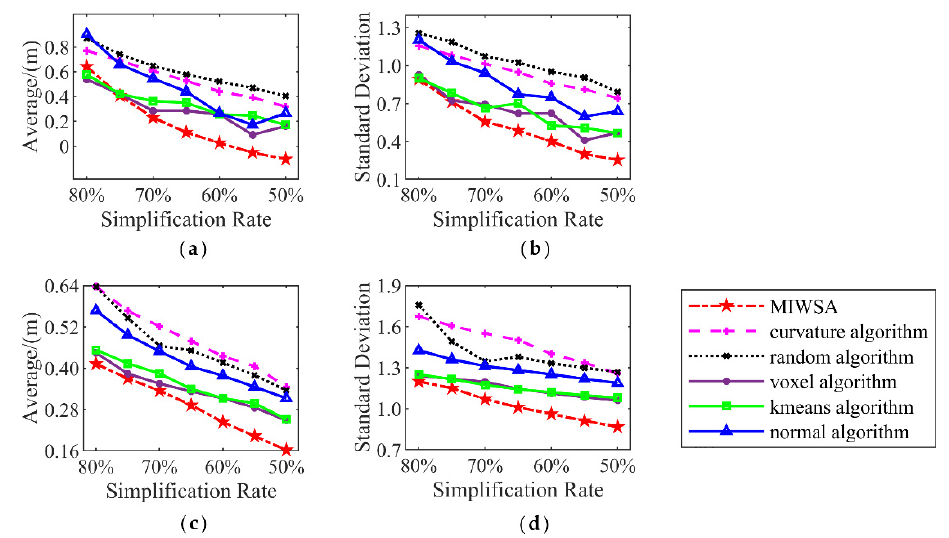
Figure 12. Mean and RMS of elevation difference: ( a ) Mean of elevation difference of Samp52; ( b ) RMS of elevation difference of Samp52; ( c ) Mean of elevation difference of Samp53; ( d ) RMS of elevation difference of Samp53.